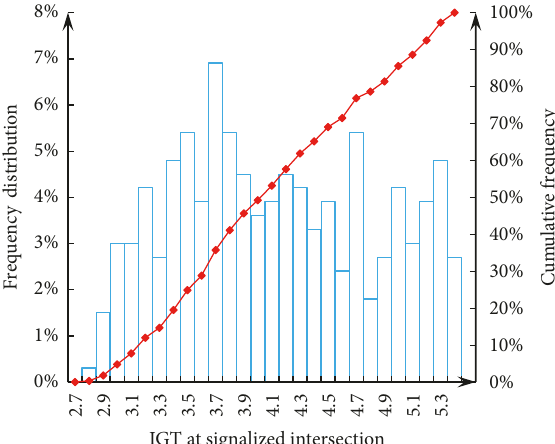
Figure 5: The frequency distribution histogram and cumulative curve